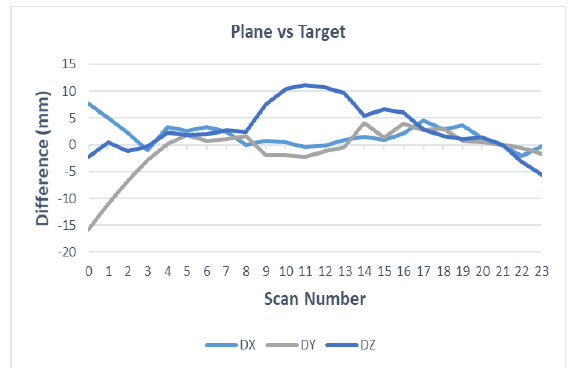
Figure 11. Case Study 1: differences on the computed scan locations between the plane- and target-based methods.